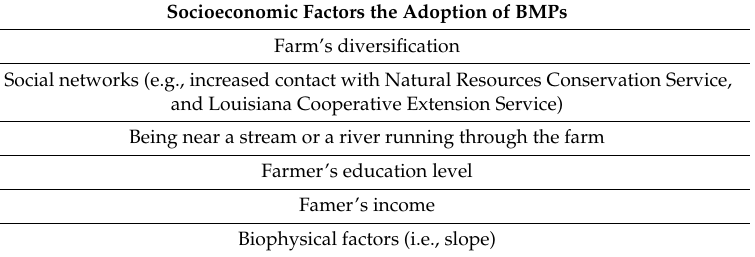
Table 1. Factors affecting the adoption of best management practices in beef cattle production, by order of importance, according to [19].